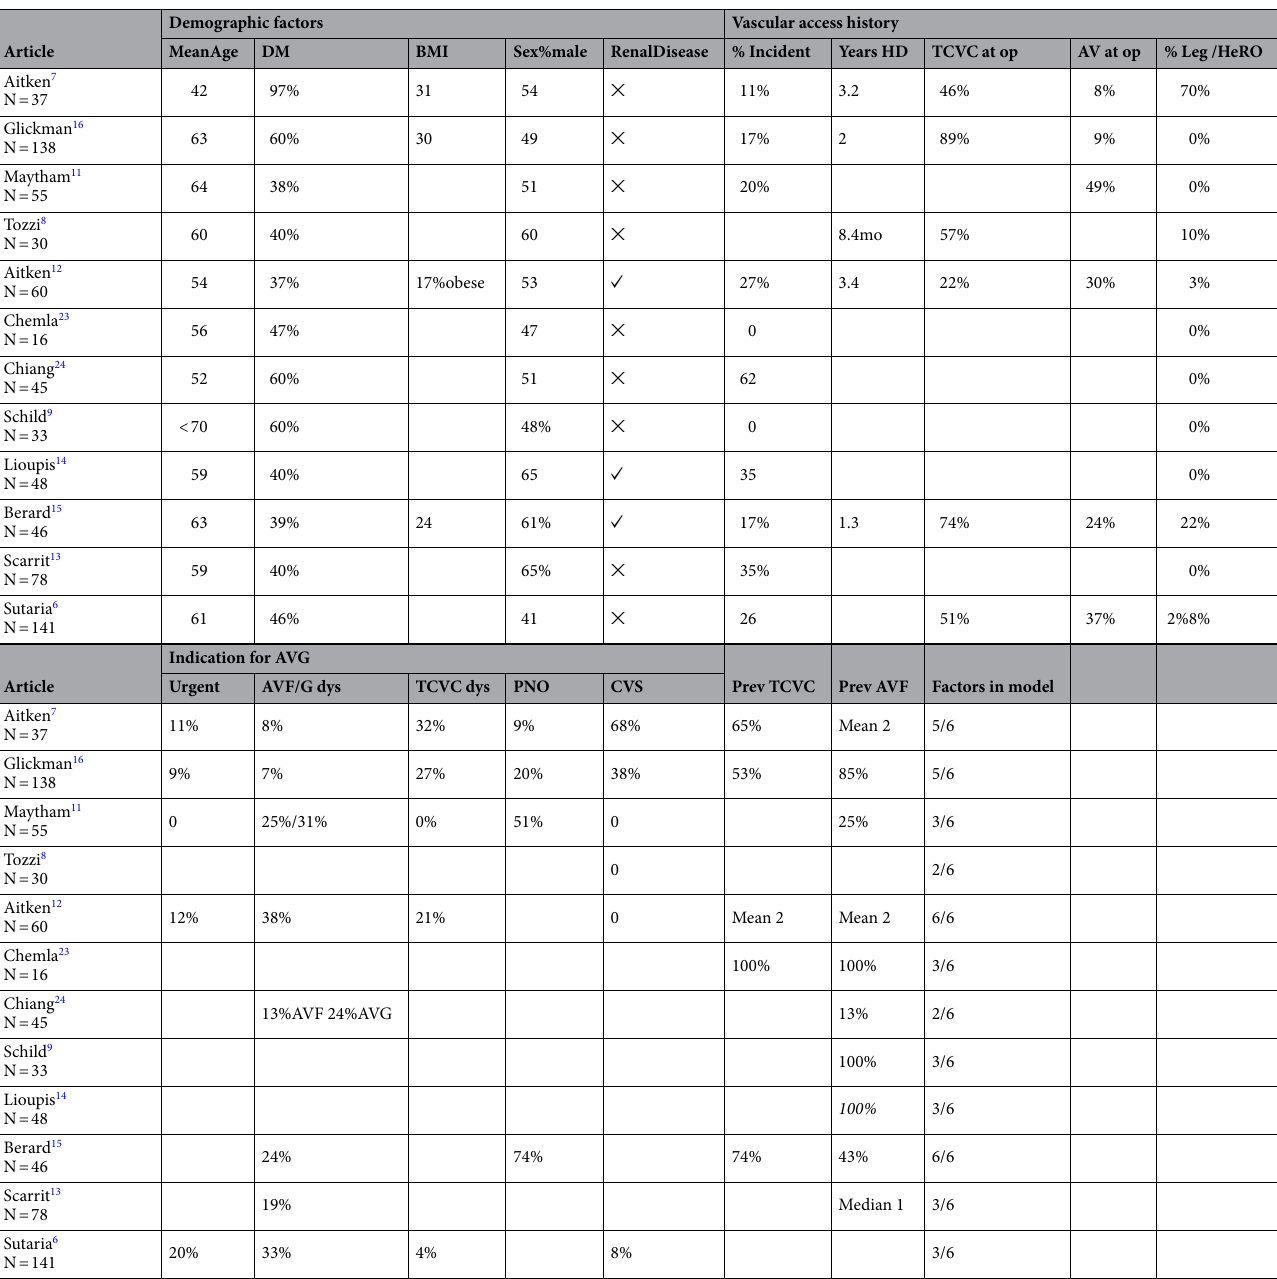
Table 1. Case-mix of case-reports of early-cannulation arteriovenous grafts. DM diabetes mellitus, BMI body mass index, Years HD years on haemodialysis prior to ecAVG, TCVC at op presence of a TCVC at time of ecAVG operation, AV at op arteriovenous fistula at time of ecAVG operation, leg/HeRO lower limb or haemodialysis reliable outflow device used due to central venous stenosis. Shading, predictors in multi-variate model, Primary diagnosis, underlying cause of renal disease; HD hemodialysis, TCVC tunnelled central venous catheter, Op operation to implant ecAVG, AV arteriovenous fistula or graft, LL lower limb, HeRO hemodialysis reliable outflow device, AVF/G Dys dysfunction of an existing AVF or AVG, TCVC Dys dysfunction of a previously functioning TCVC, PNO poor native options, CVS central vein stenosis, Factors in model, number of factors documented in methods in the predictive